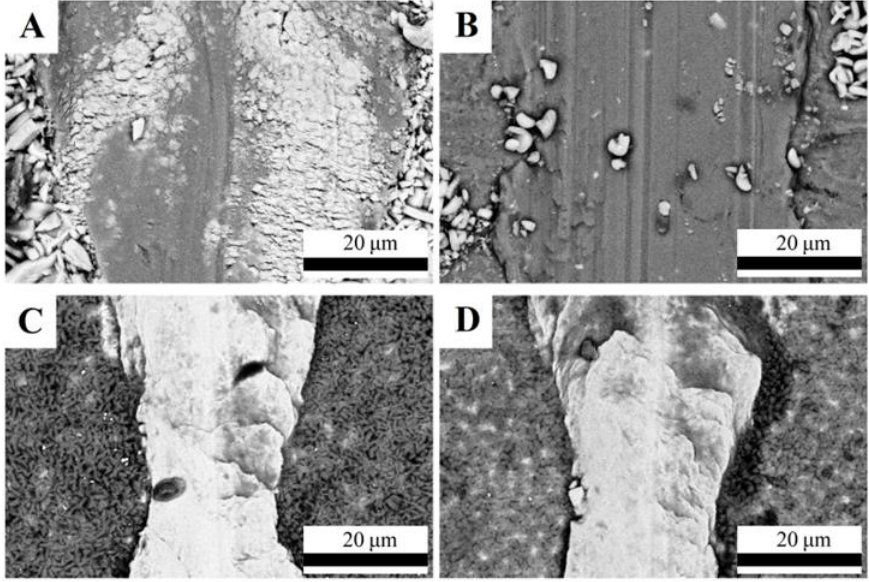
Figure 9. Pressure channel formed after scratch test: AL2-N ( A ), AL2-NG ( B ), ST-N ( C ), ST-NG ( D ).